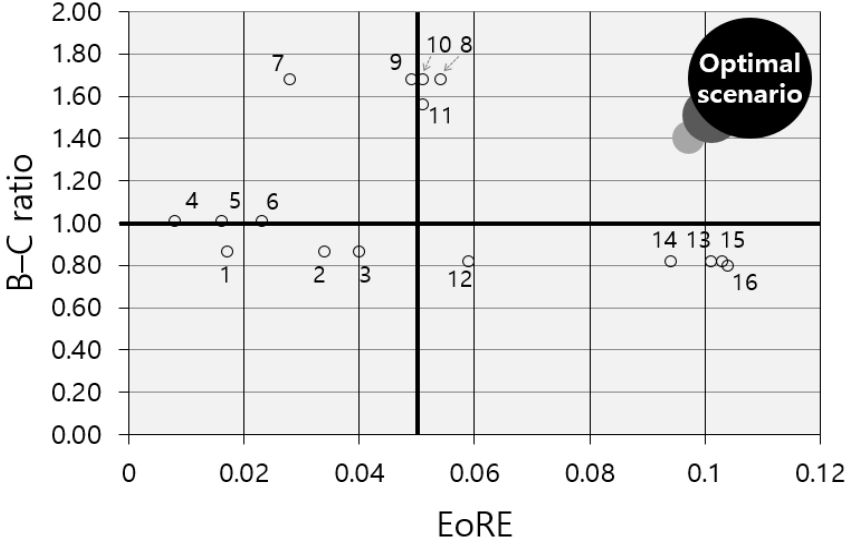
Figure 9. Results of EoRE and B–C ratio for each scenario in the failure of three facilities. Table 4. CBA result that satisfied CR.